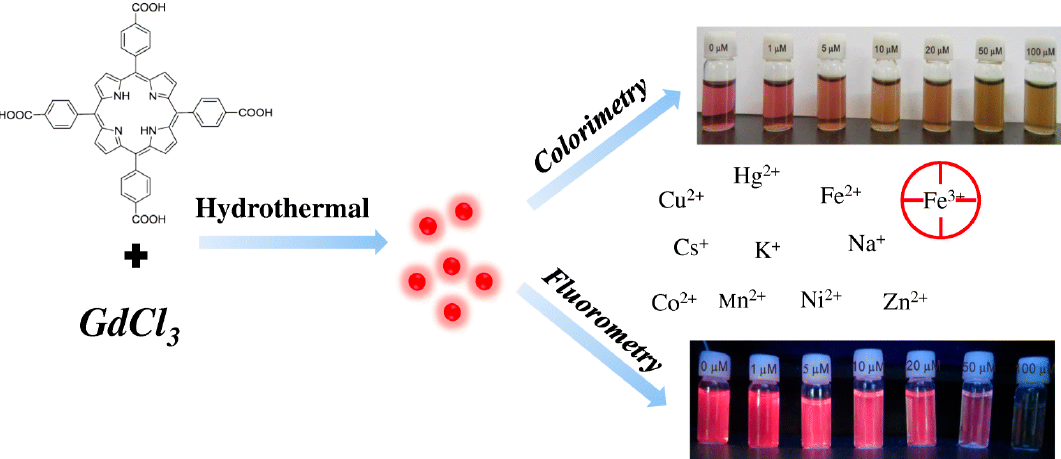
Figure 11. Schematic illustration of Gd − TCPP (5,10,15,20-tetrakis (4 carboxyphenyl) porphyrin) nanosized coordination polymer for Fe 3+ detection in the colorimetric and fluorometric modes. Reprinted with permission from ref [53]. Copyright 2019 Springer link.